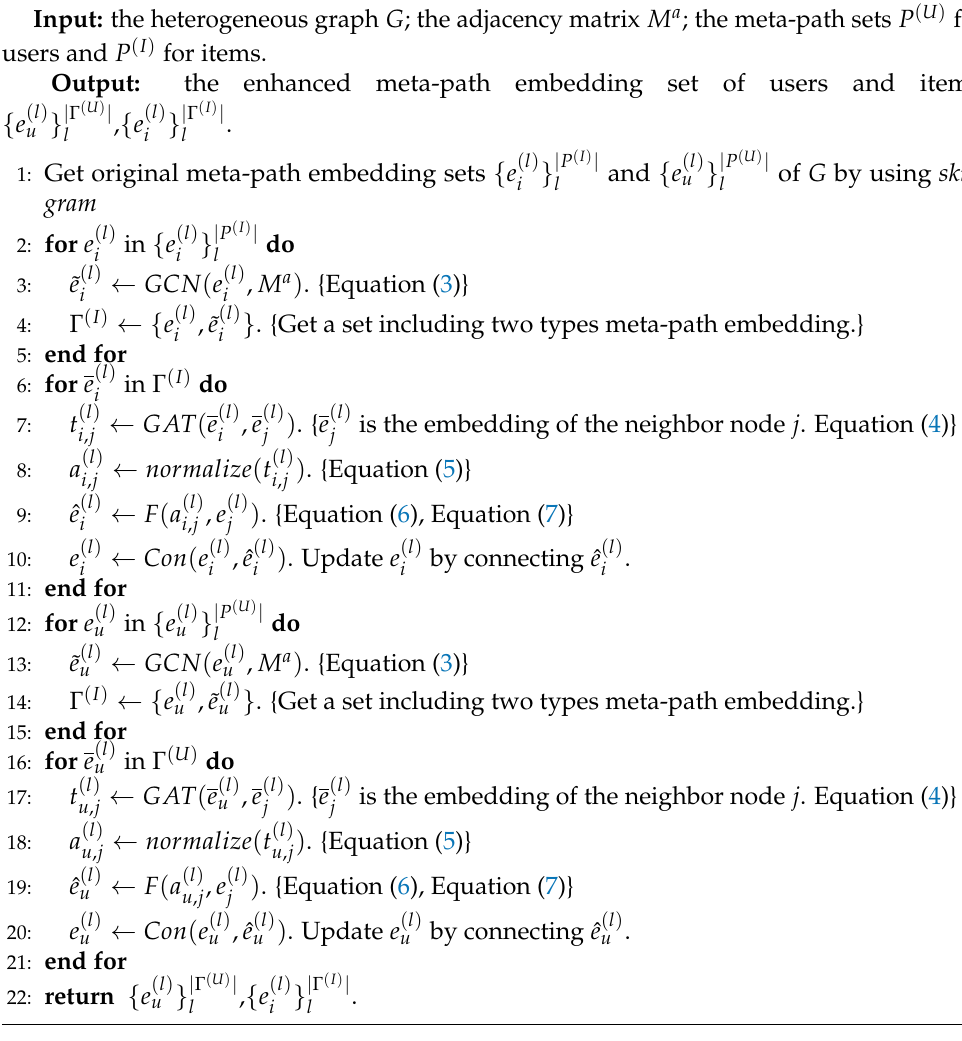
Algorithm 1: Algorithm for enhancing meta-path